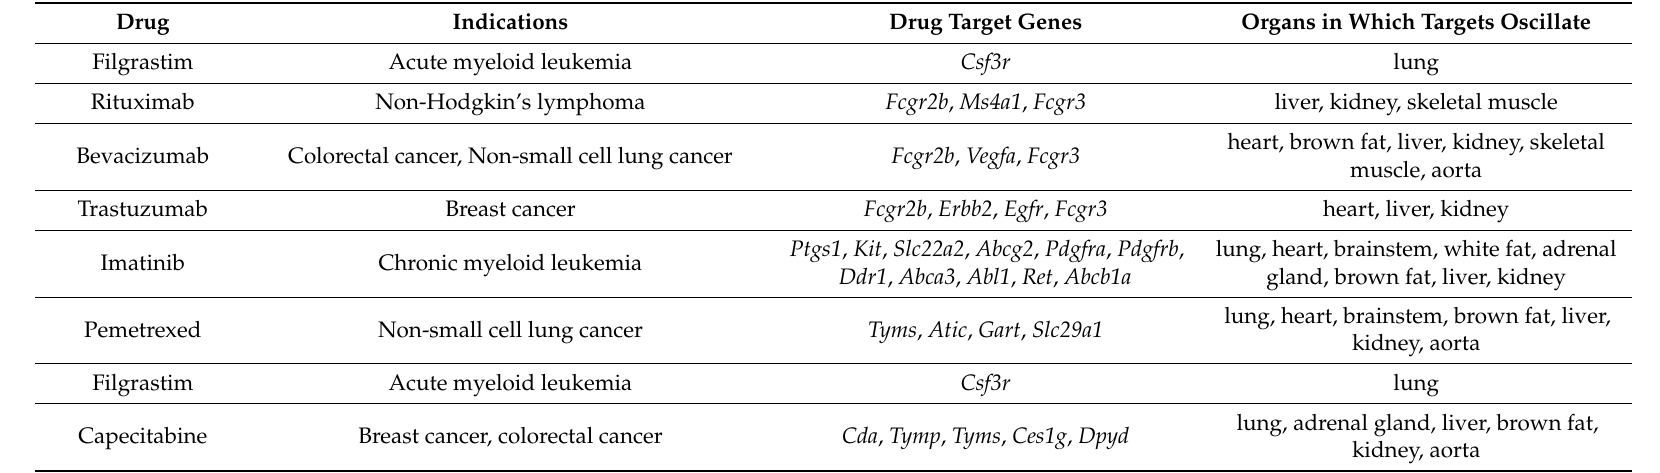
Table 2. Cancer-related drugs from the top-100 best-selling drugs list that target circadian genes and have half-life < 6 h. Information extracted from